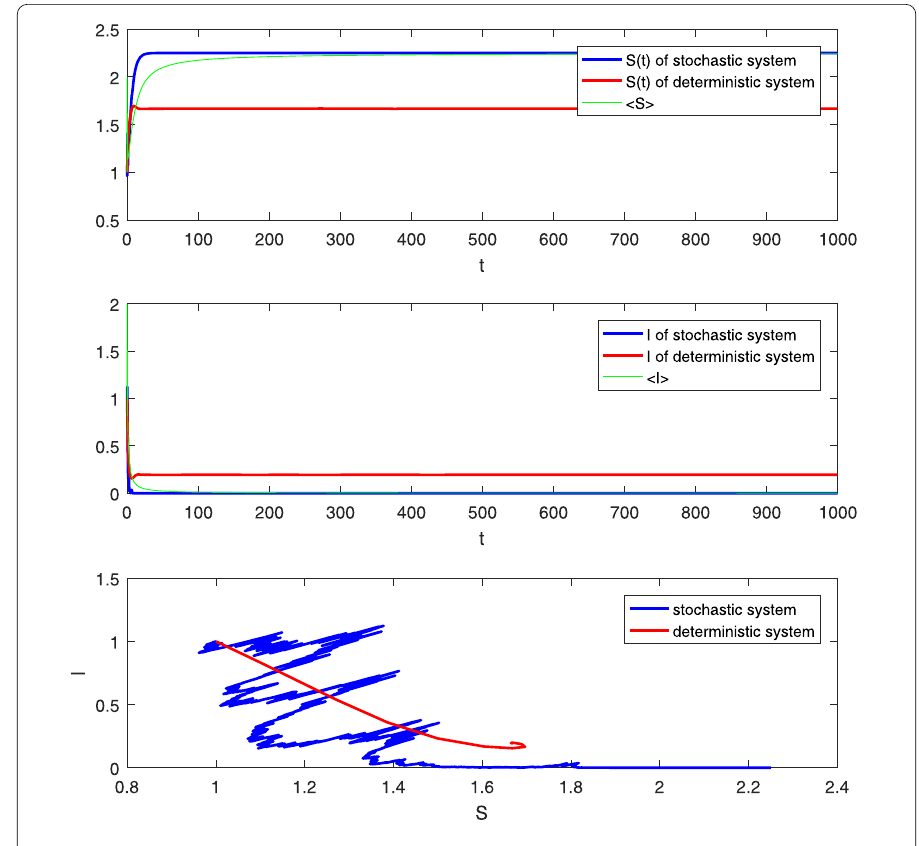
Figure 4 Comparison illustration for S ( t ), I ( t ) of deterministic system and stochastic system with σ = 0.3, Λ = 0.45, μ = 0.2, β = 0.5, γ = 0.79, α = 0.4, p = 2, where R = 1.8210 > 1, R ∗ = 0.9913 < 1